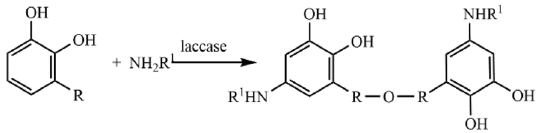
Figure 3. Reaction mechanism of LF.